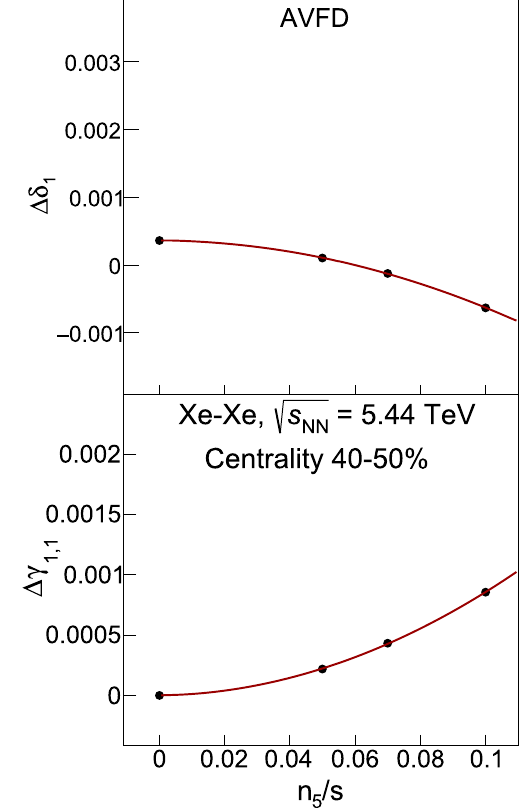
Fig. 8 The dependence of (cid:9)δ 1 and (cid:9)γ 1 , 1 in the upper and lower pan- els, respectively, on the axial current density n 5 / s in the analysed sam- √ s NN = 5 . 02TeVforthe40–50%centrality plesofXe–Xecollisionsat interval